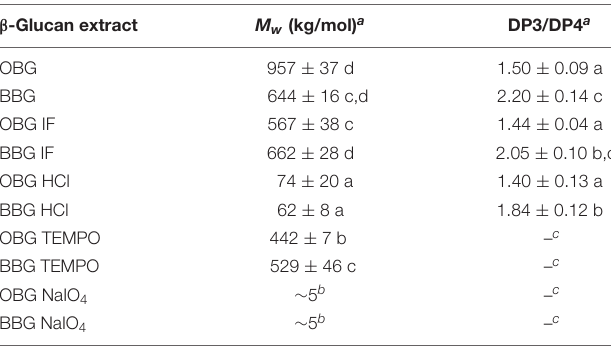
TABLE 2 | Weight-average molecular weights ( M w ) and molar DP3/DP4 ratios determined by means of HPSEC and lichenase treatment/HPAEC-PAD,